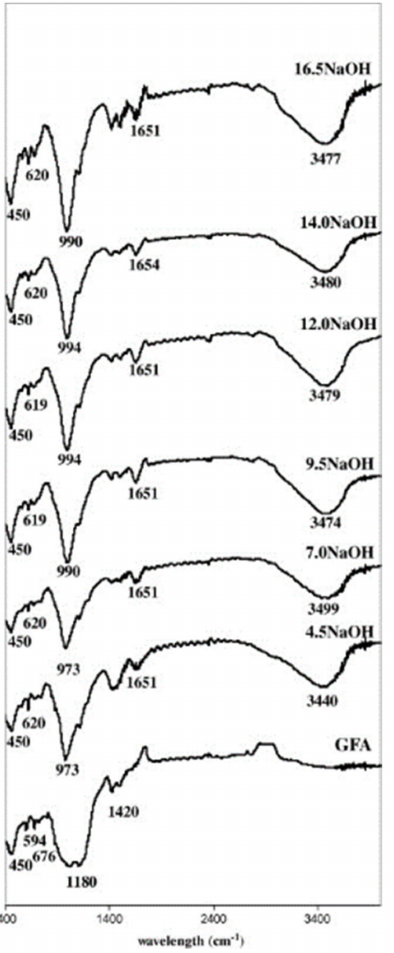
Figure 10. FT-IR spectra of FA-based geopolymer cement: influence of molarity solution. Reprinted with permission from Ref. [53]. Copyright 2014 Elsevier.